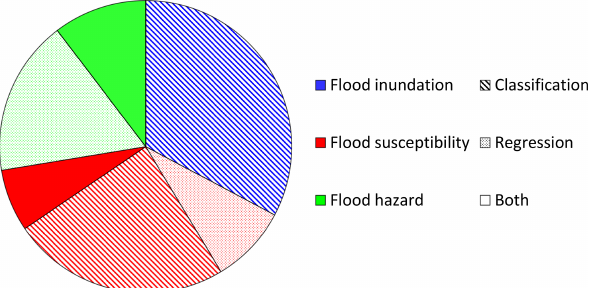
Figure 7. Distribution of the comparison metrics per type of ap- plication. The colors represent the different types of applications, while the patterns represent the considered